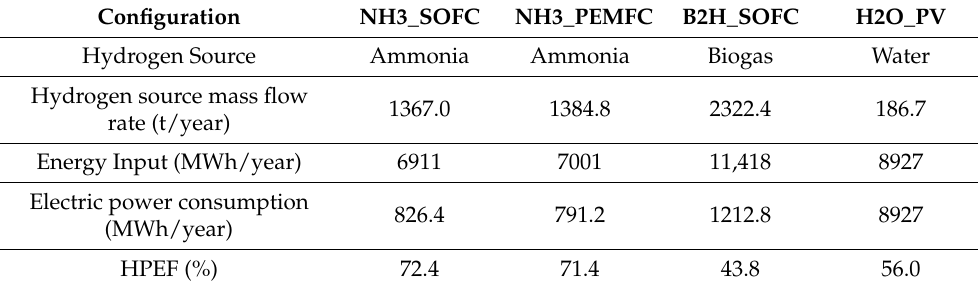
Table 2. Annual performances of the proposed HRS plants with a hydrogen capacity of 150